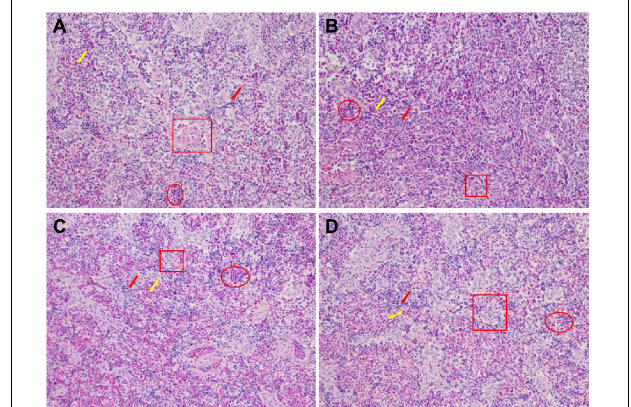
FIGURE 3 | Histological examination images in spleen of hybrid grouper fed diets containing different oxidized fish oil level (magnification 200). R group (A) , L group (B) , M group (C) , and H group (D) . The red arrow represents the white pulp; the yellow arrow represents the red pulp; the red square represents the small arteries; the red ellipse represents the blood